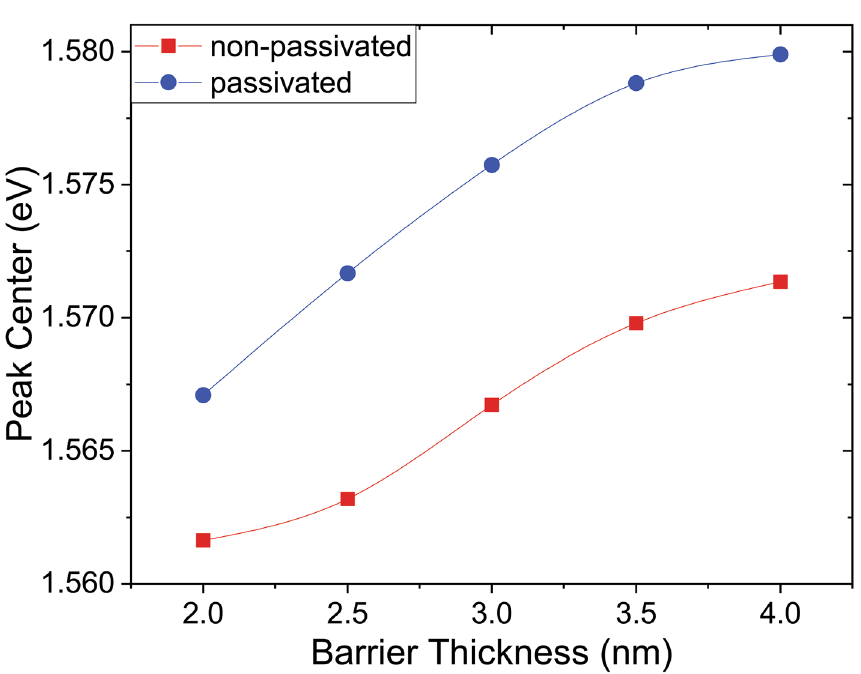
Figure 4. Change in PL peak positions of SiNC samples with varied barrier thicknesses measured at 80 K. The curves connecting the data points are just visual